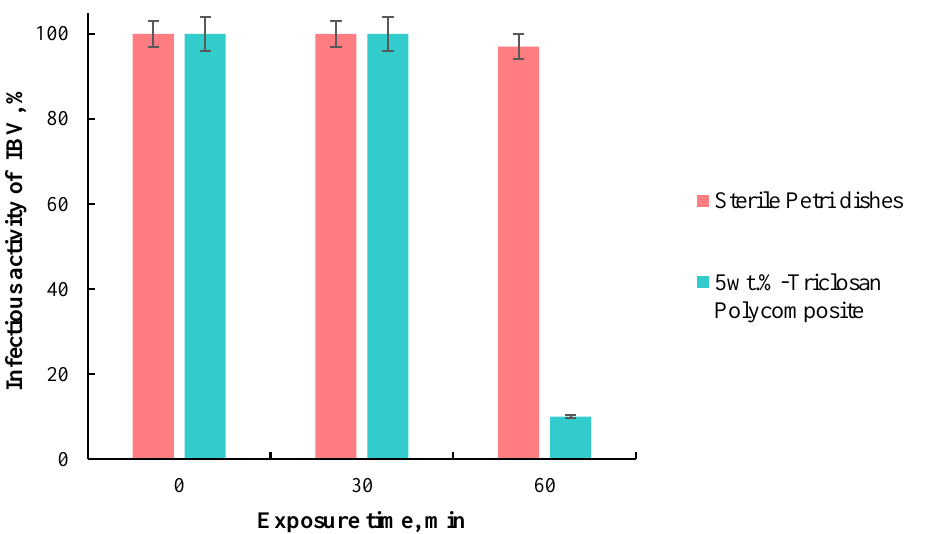
Figure 6. Infectious activity of IBV after 60 min of incubation on sterile Petri dishes and polymer composite.